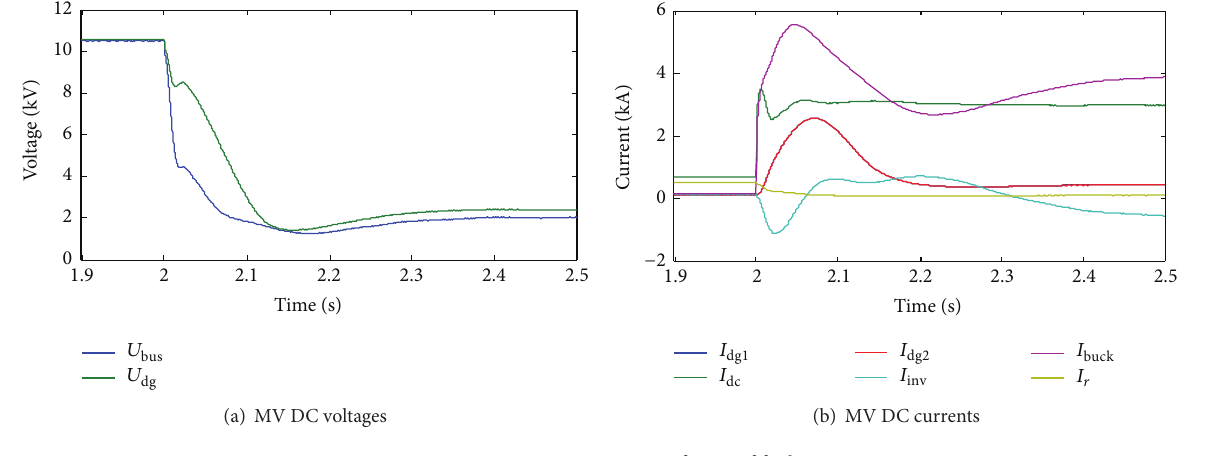
Figure 9: Transient response waveforms of fault F3.